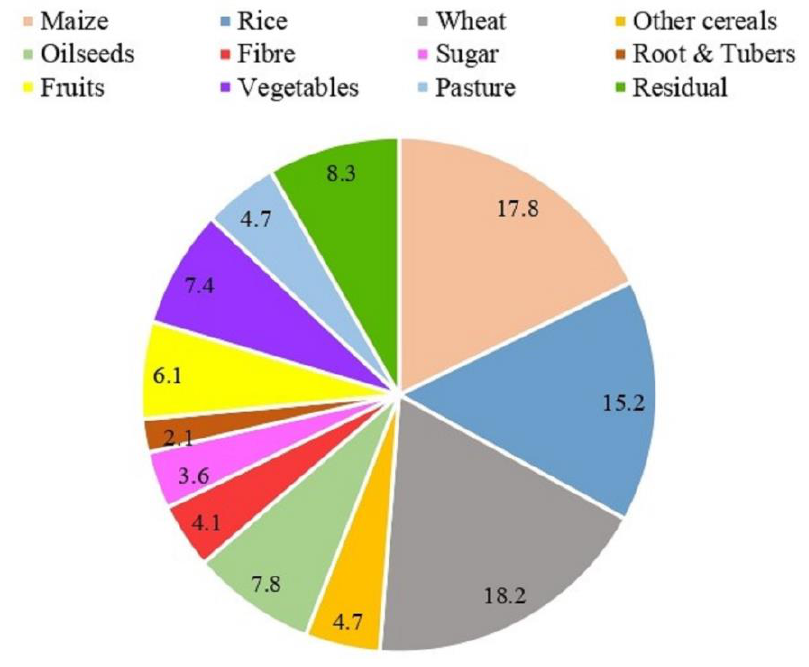
Figure 1. Crop-wise N fertilizer consumption (%).